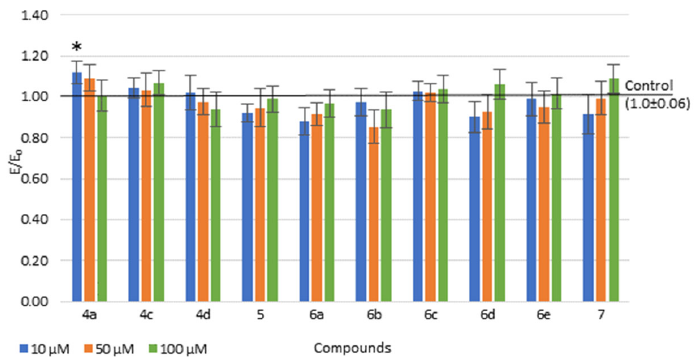
Figure 8. Effect of tested compounds on ROS level on NHDF cells; * p < 0.05–significant difference